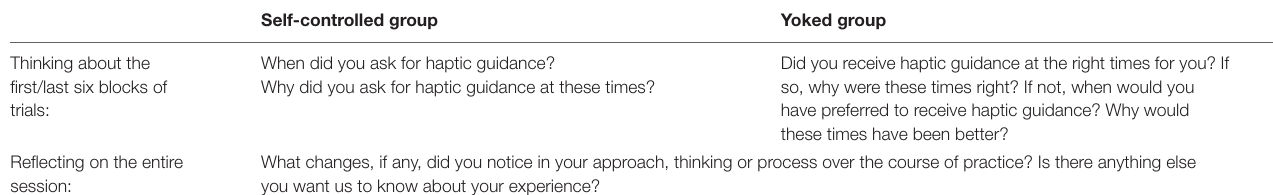
TABLE 1 | Open-ended questions asked of self-controlled and yoked participants at the end of skill acquisition. Self-controlled